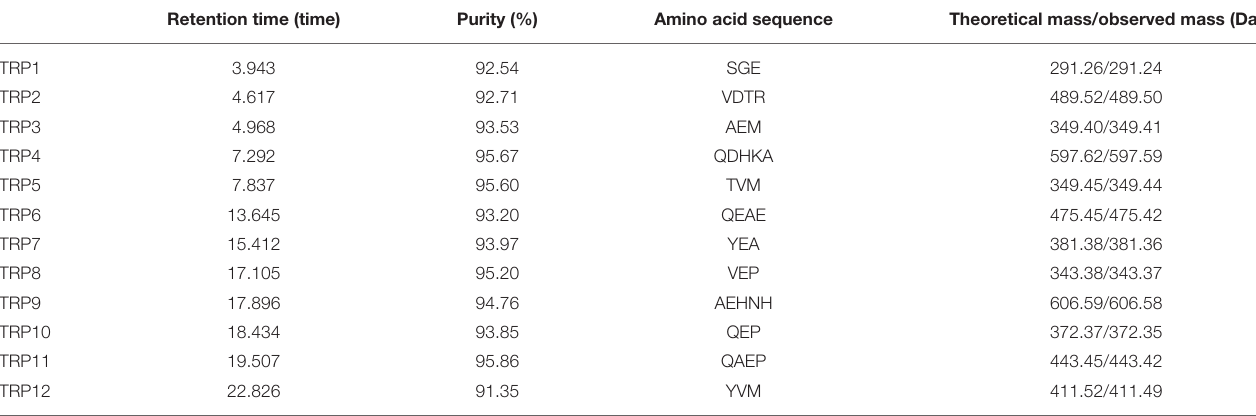
TABLE 2 | Retention time, purity, amino acid sequences, and molecular weights of 12 isolated APs (TRP1 to TRP12) from protein hydrolysate (TRPH) of skipjack tuna ( Katsuwonus pelamis ) roe prepared by Flavourzyme. Retention time